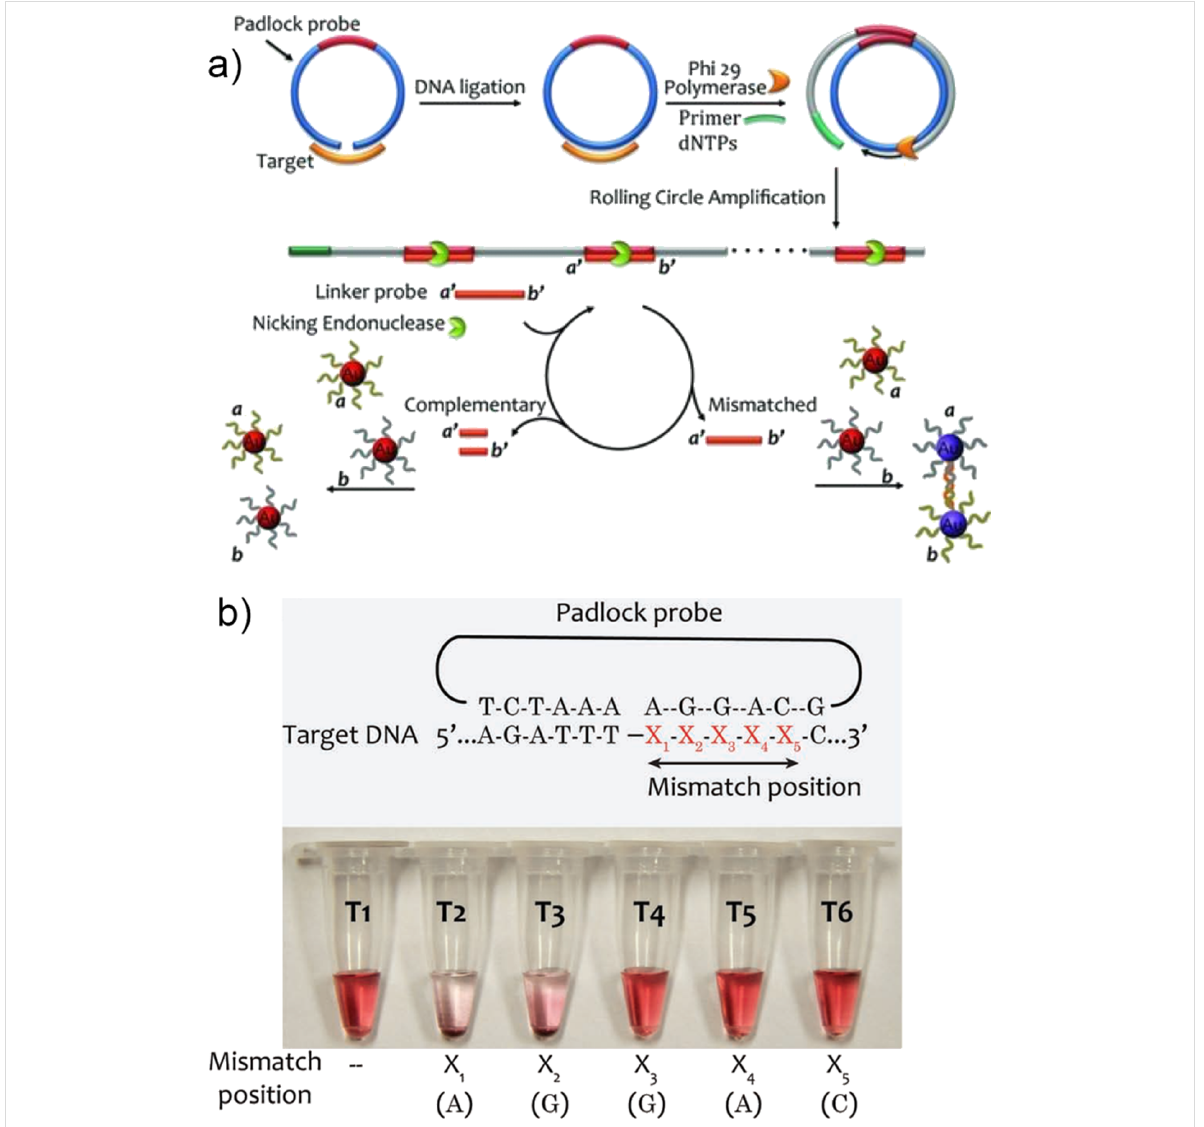
Figure 12: Colorimetric DNA detection through rolling circle amplification (RCA) and NEase-assisted nanoparticle amplification (NEANA). a) Working principle of the assay. b) Colorimetric detection of single-point mutation located in the proximity of ligation point. Reprinted with permission from [110], copyright 2012 John Wiley and